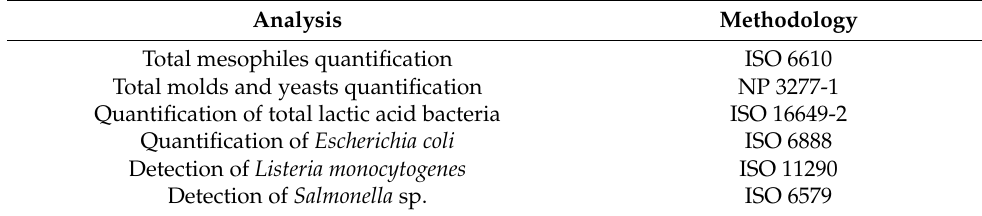
Table 2. Microbial analyses and methodologies performed for evaluating the microbial stability of